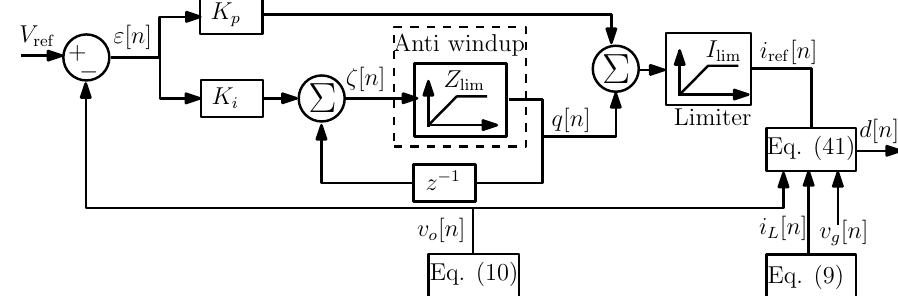
Figure 9. Block diagram of the large-signal model of the system with a double control loop based on the proposed DSMC.